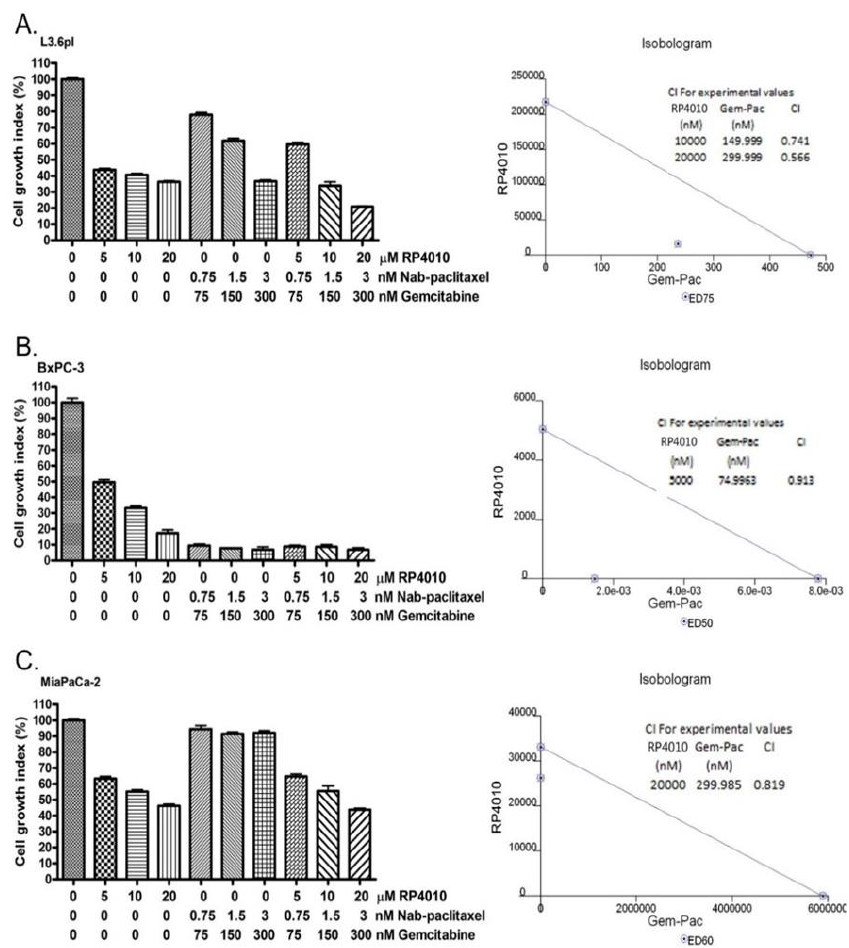
Figure 4. RP4010 and gemcitabine / nab-paclitaxel showed synergistic effects on the inhibition of cell proliferation in vitro. L3.6pl ( A ), BxPC-3 ( B ) and MiaPaCa-2 ( C ) cells were exposed to the indicated concentrations of either RP4010 alone or gemcitabine / nab-paclitaxel, or a combination of RP4010 with gemcitabine / nab-paclitaxel for 72 h, and cell proliferation was evaluated by MTT assay as described in Methods ( n = 2). CalcuSyn software was employed to generate isobolograms (shown on the right-hand side panel) and determine CI values from the resulting data.